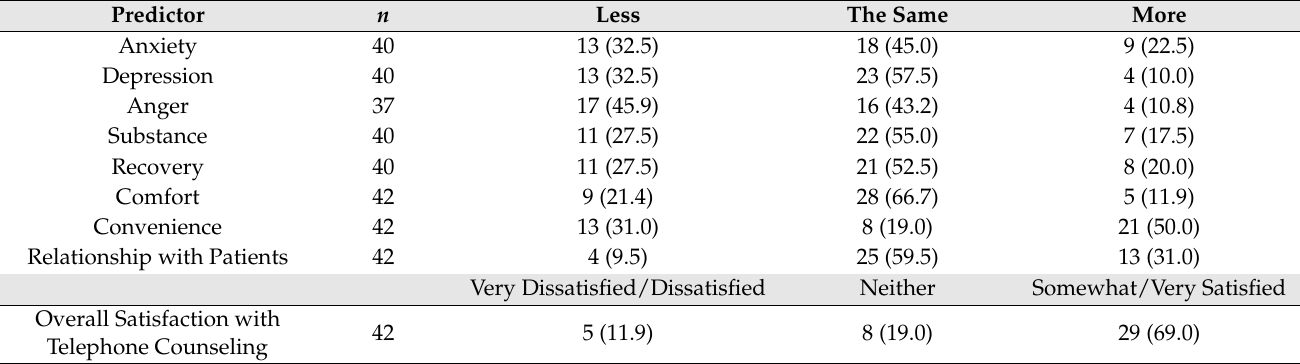
Table 1. Frequencies for Anxiety, Depression, Anger, Substance, Recovery, Comfort, Convenience, Relationship with Patients, and Overall Satisfaction.